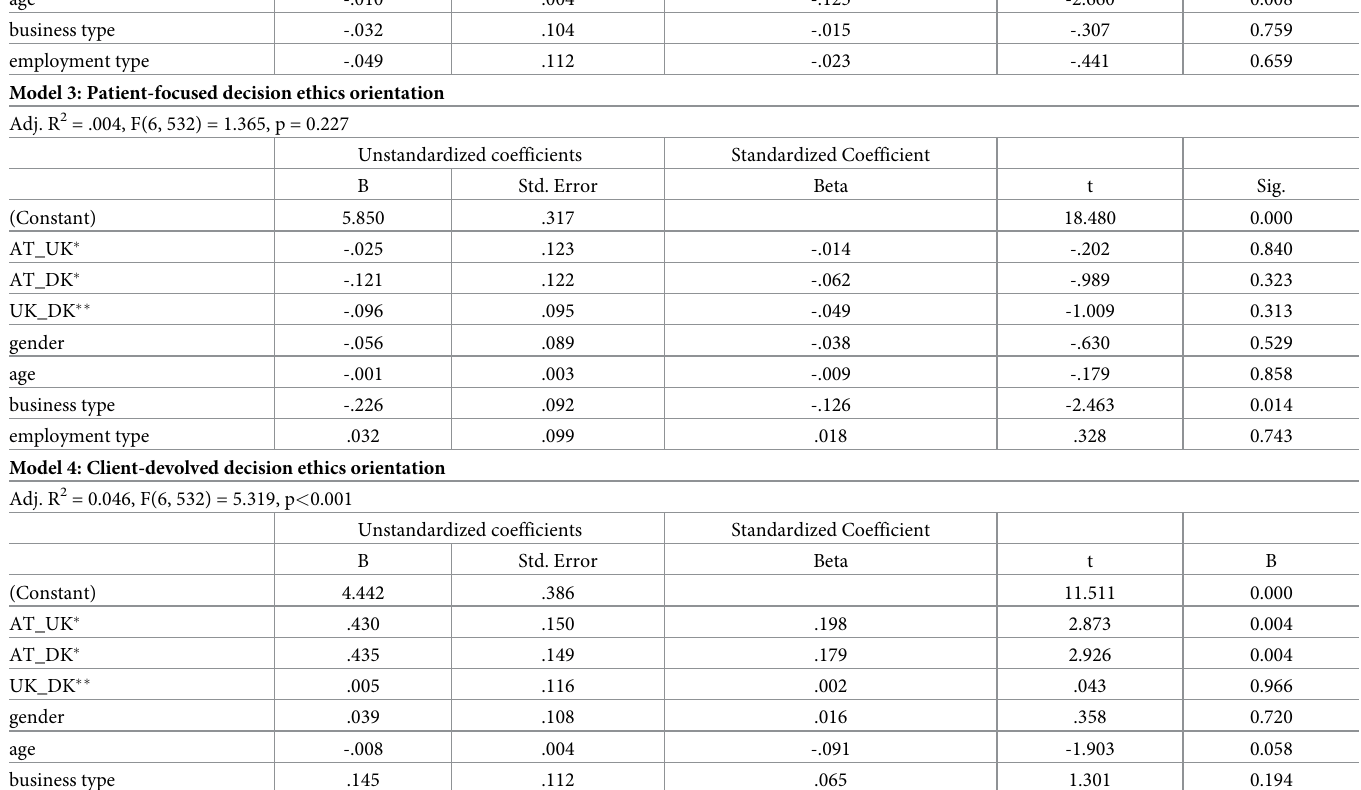
Model 4: Client-devolved decision ethics